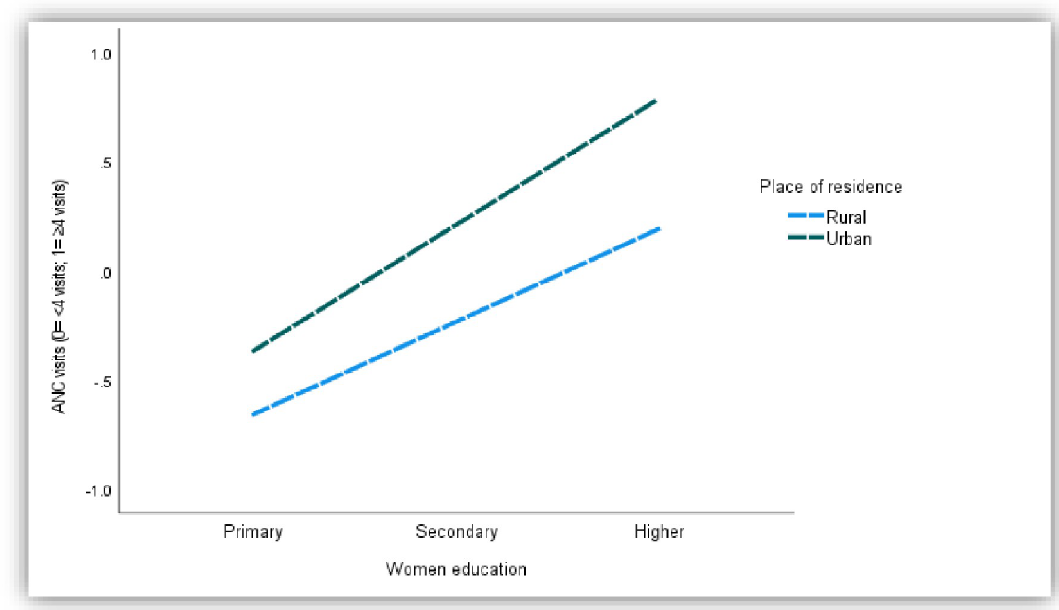
Fig 4. Plot of the relationship (moderated mediation) between ANC and women education at -1sd and +1sd place of residence (Conditional effect of the focal predictor).